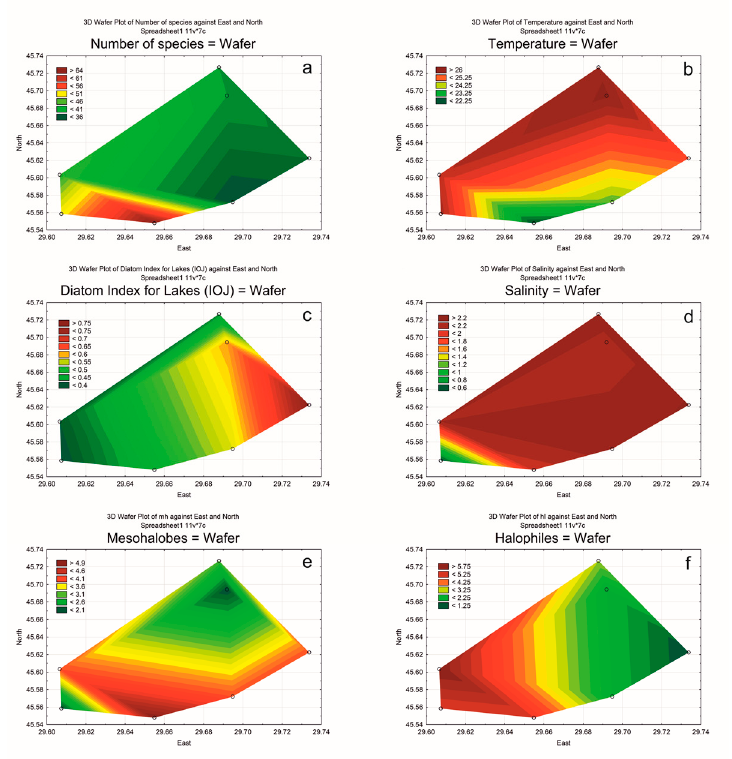
Figure 3. Statistically generated maps of phytobenthic assemblage data from Table 1 and Table S1 (( a )—number of species, ( e )—mesohalobes, and ( f )—halophiles indicators). ( c )—Diatom Index for the lakes as well as chemical parameters of water (( b )—temperature and ( d )—salinity) on the surface water of the Sasyk Reservoir during August